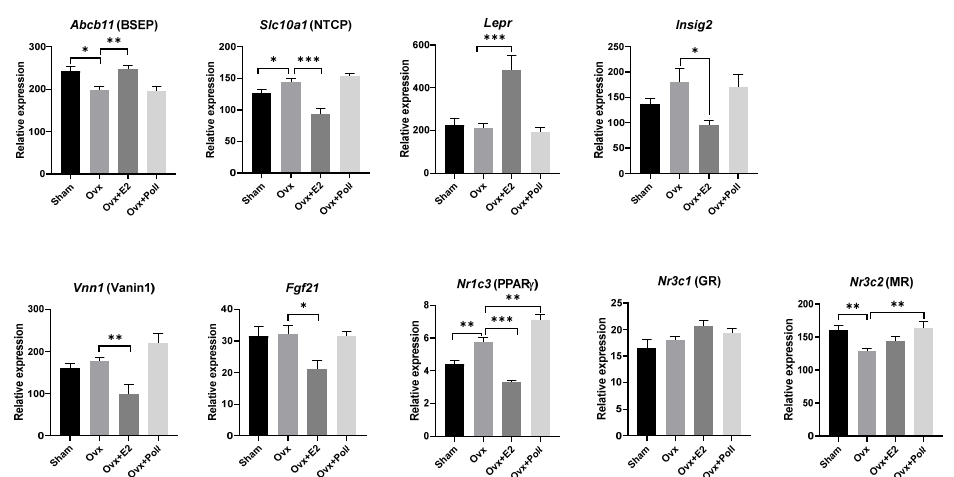
Figure 5. Effect of ovariectomy alone (Ovx) or with 17 β -estradiol (E2) supplementation (Ovx+E2) or with exposure to pollutants (Ovx + Poll) on the expression of genes encoding various nuclear receptors and target genes, and BA transporters in the liver. Values are means ± SEM with n = 6–8. *** p < 0.001; ** p < 0.01; * p < 0.05. Sham: Sham-operated mice.